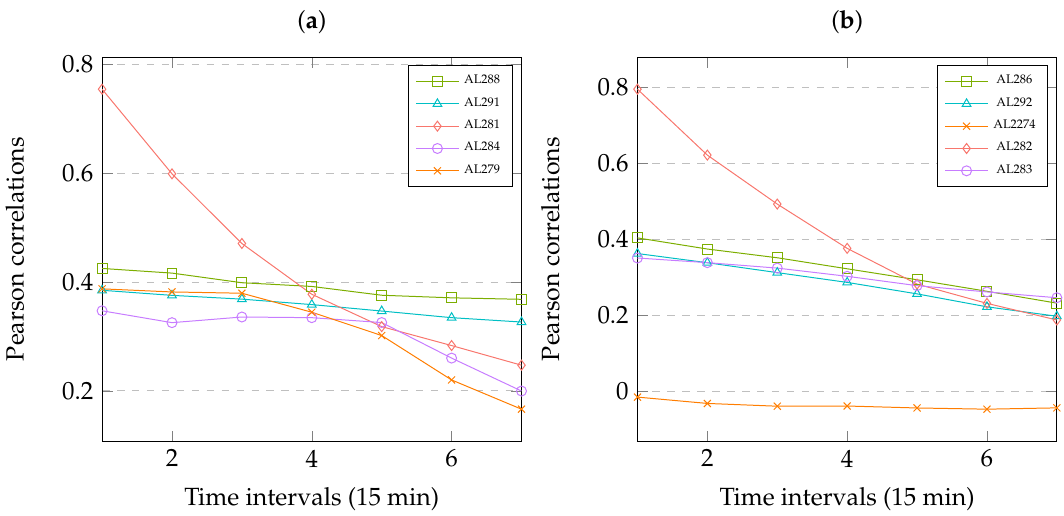
Figure 5. Correlations in multiple links. ( a ) Time intervals on Link AL281. ( b ) Time intervals on Link